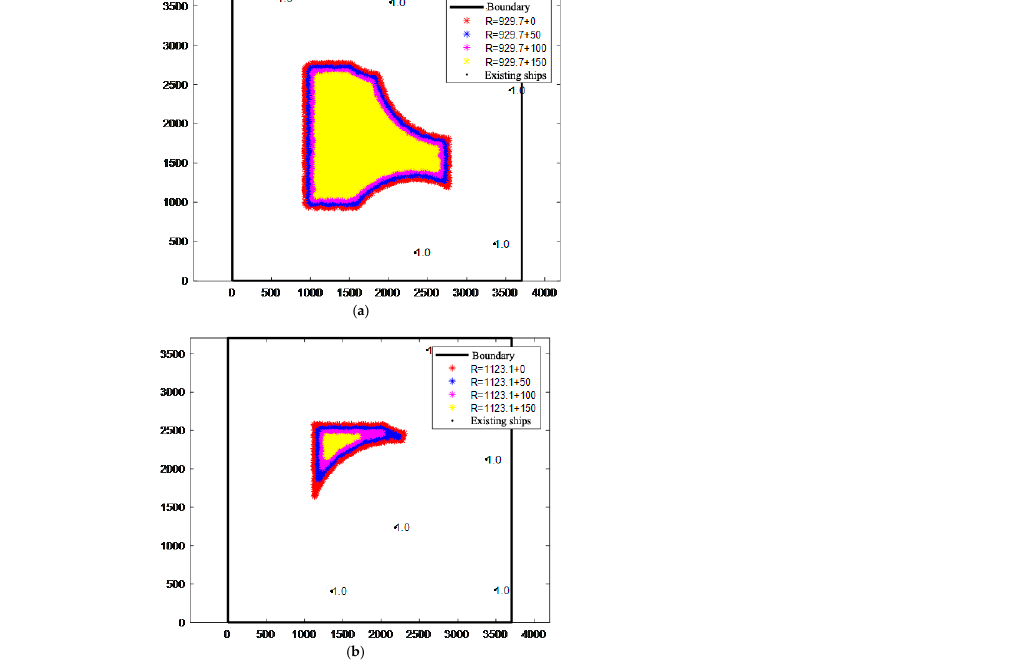
Figure 10. Schematic diagram of mooring area detection with wind force >7 and water depth of 20 m. ( a ) Represents 192 m and 192 m ship type mooring area detection. ( b ) Represents 333 m and 333 m ship type mooring area detection.